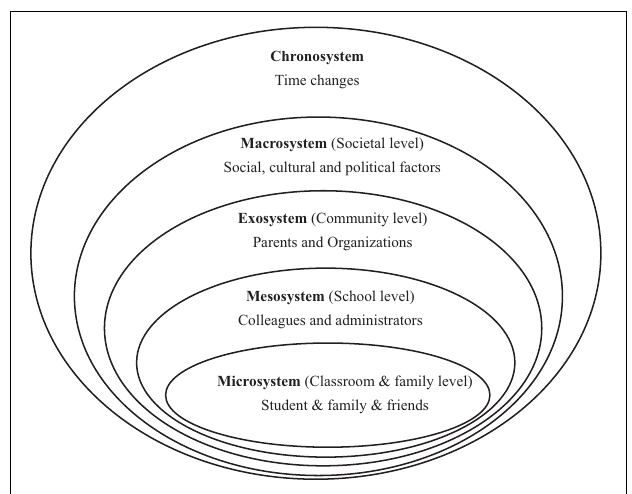
emotional development process of two Chinese senior high school English